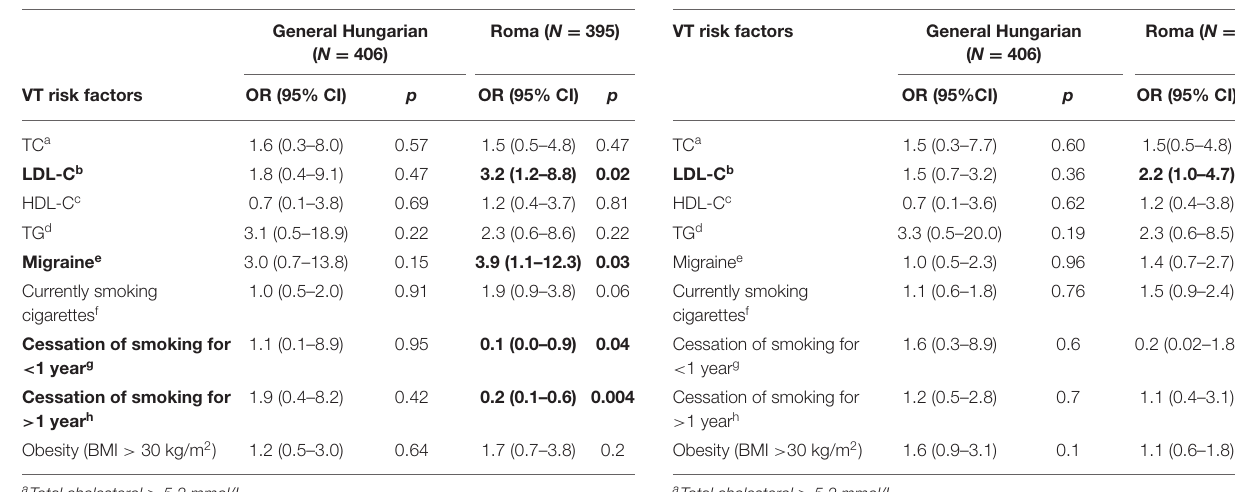
TABLE 5 | Association between wGRS and VTE risk factors.